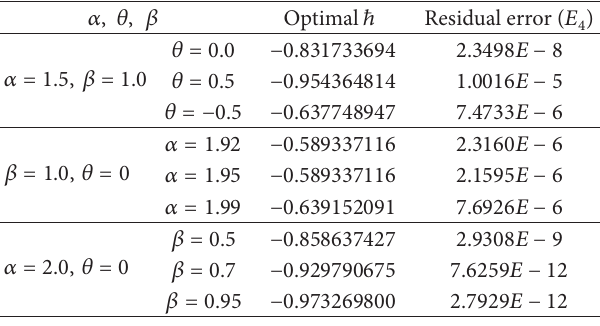
Table 2: The estimated optimal convergence parameter ℏ and the corresponding residual error 𝐸 𝑚 at different fractional parameters used in Example 12.